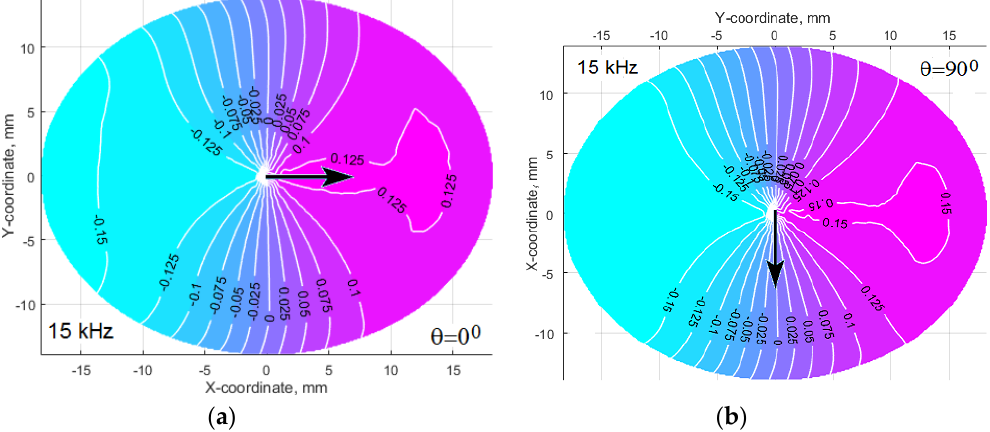
Figure 13. The distribution of the interfacial tangent radial displacements in μ m at the excitation frequency 15 kHz. Actuator’s axis is oriented along ( a ) and across ( b ) the main orthotropy axis of the CFRP panel, which is denoted by the arrows.